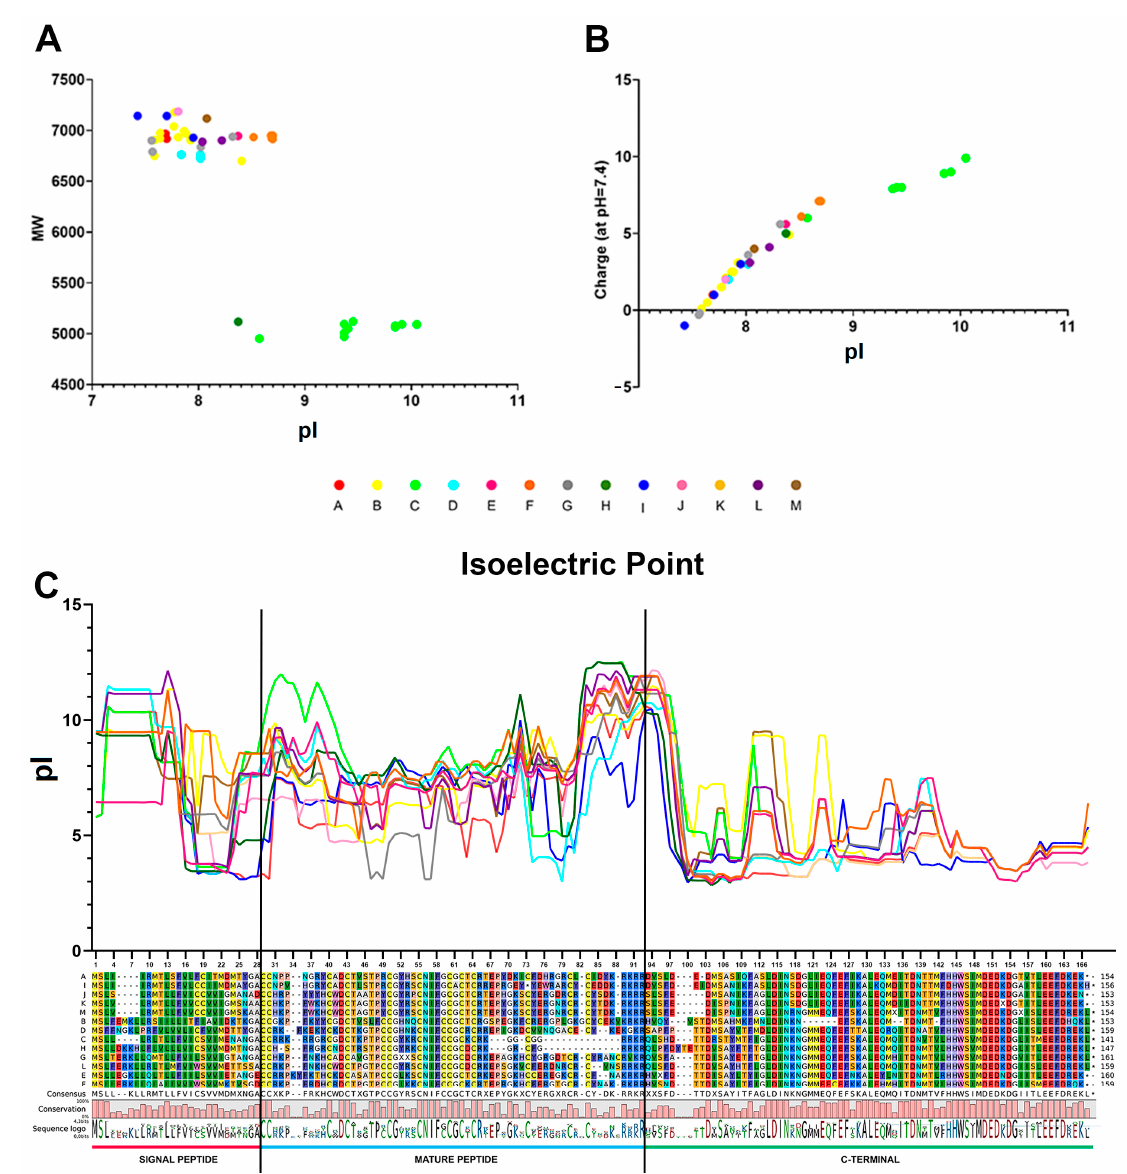
Figure 4. Isoelectric Point. ( A ) Isoelectric point (X axis) and molecular weight (Y axis) of the mature peptide of mytimycins with an uninterrupted CDS. ( B ) Isoelectric point (X axis) and charge at pH = 7.4 (Y axis) of the mature peptide of mytimycins with an uninterrupted CDS. ( C ) Isoelectric point of the whole sequence of the 13 mytimycin isoforms (consensus sequence of each isoform). The isoelectric point distribution was analyzed through the calculation of the average isoelectric point based on a sliding window of 15 amino acids. The alignment shows the consensus sequence of the 13 mytimycins clusters obtained from 16 genomes. X represents polymorphic amino acid residues found in each cluster. * represents STOP codons.